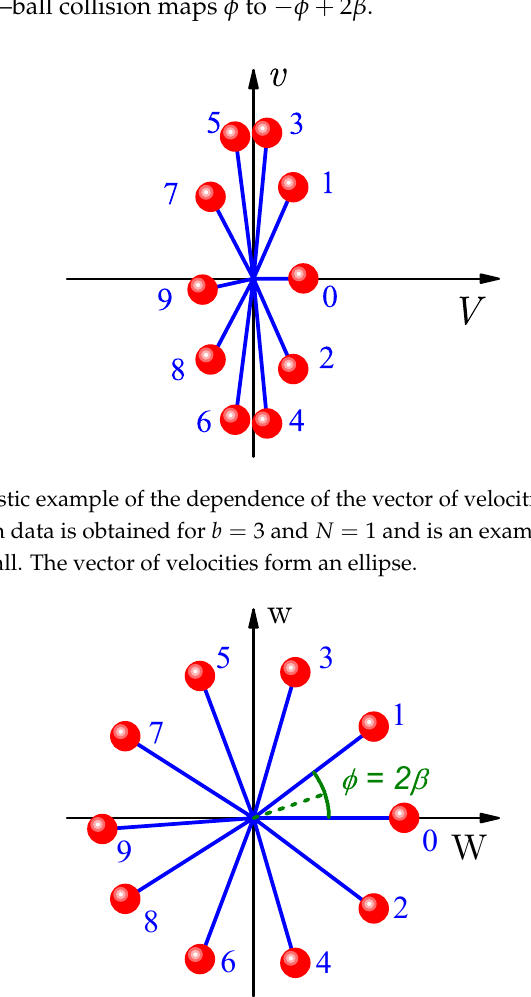
Figure 4. Same scenario as Figure 3, but now the vector of rescaled velocities w = ( W , w ) form a